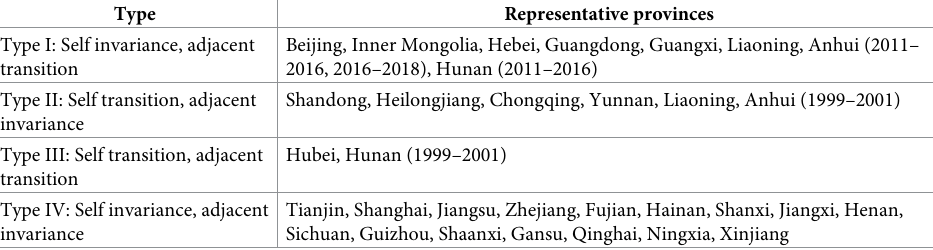
Table 8. Types of spatial transition of high-quality industrial development level and provinces covered. Type Representative